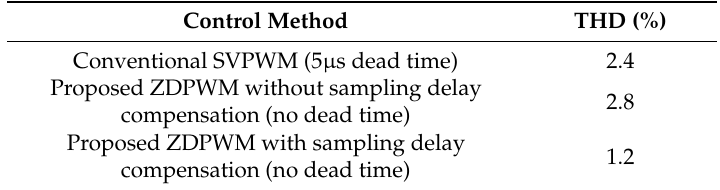
Table 4. Comparison of the THD characteristics of the conventional SVPWM and proposed